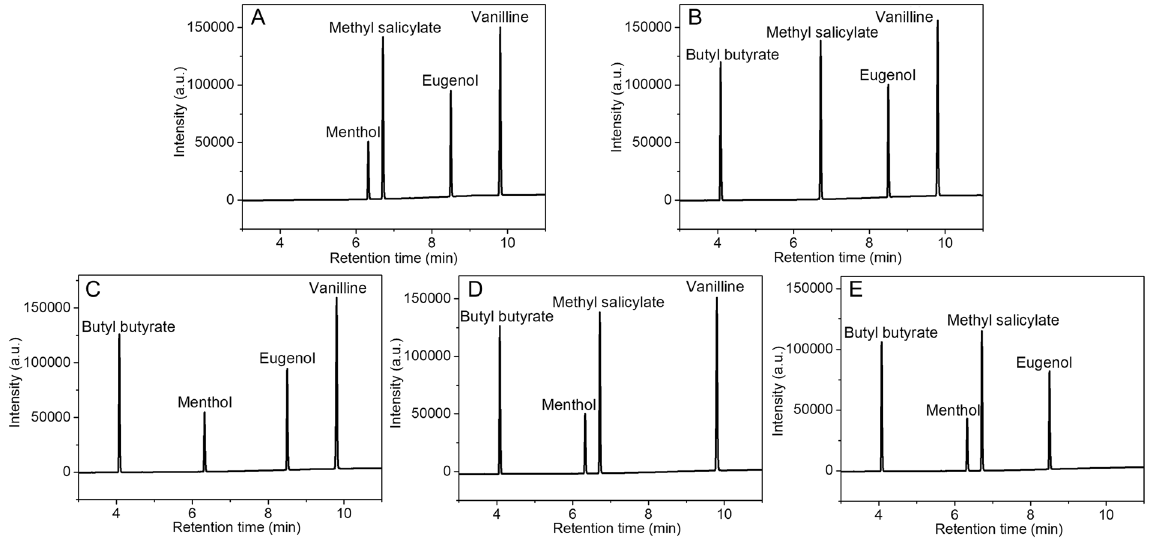
Figure 2. Gas chromatograms of four flavor agents without butyl butyrate ( A ), menthol ( B ), methyl salicylate ( C ), eugenol ( D ) and vanilline ( E ).